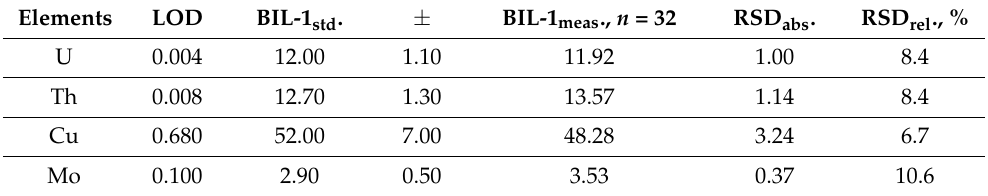
Table 1. The results of measurement of trace element content (mg/kg) in the certified reference standard BIL-1 (sediment sample from Lake Baikal). Note. LOD—limit of detection; BIL-1 std .—the standard value in the reference sample BIL-1; BIL-1 meas .—the measured value in the reference sample BIL-1; ± —the certified range of measurement error; RSD abs .—the absolute measurement error; RSD rel .—the relative measurement error; n/r—the measurement error range not calculated. Elements LOD BIL-1 std